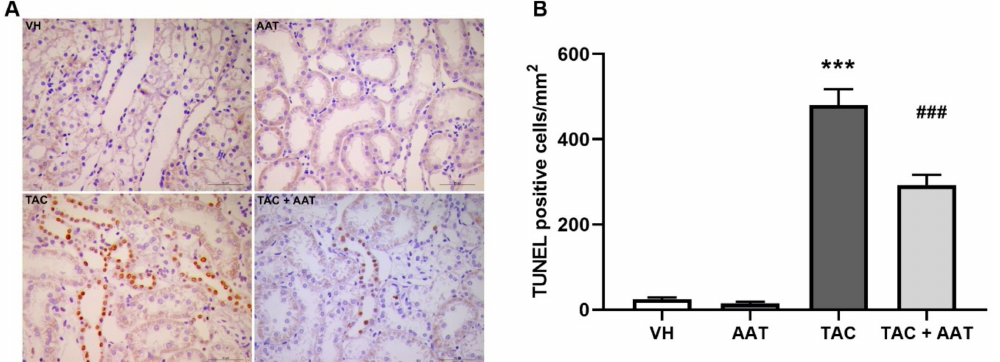
E ff ect of alpha-1 antitrypsin on apoptosis detected by terminal deoxynucleotidyl